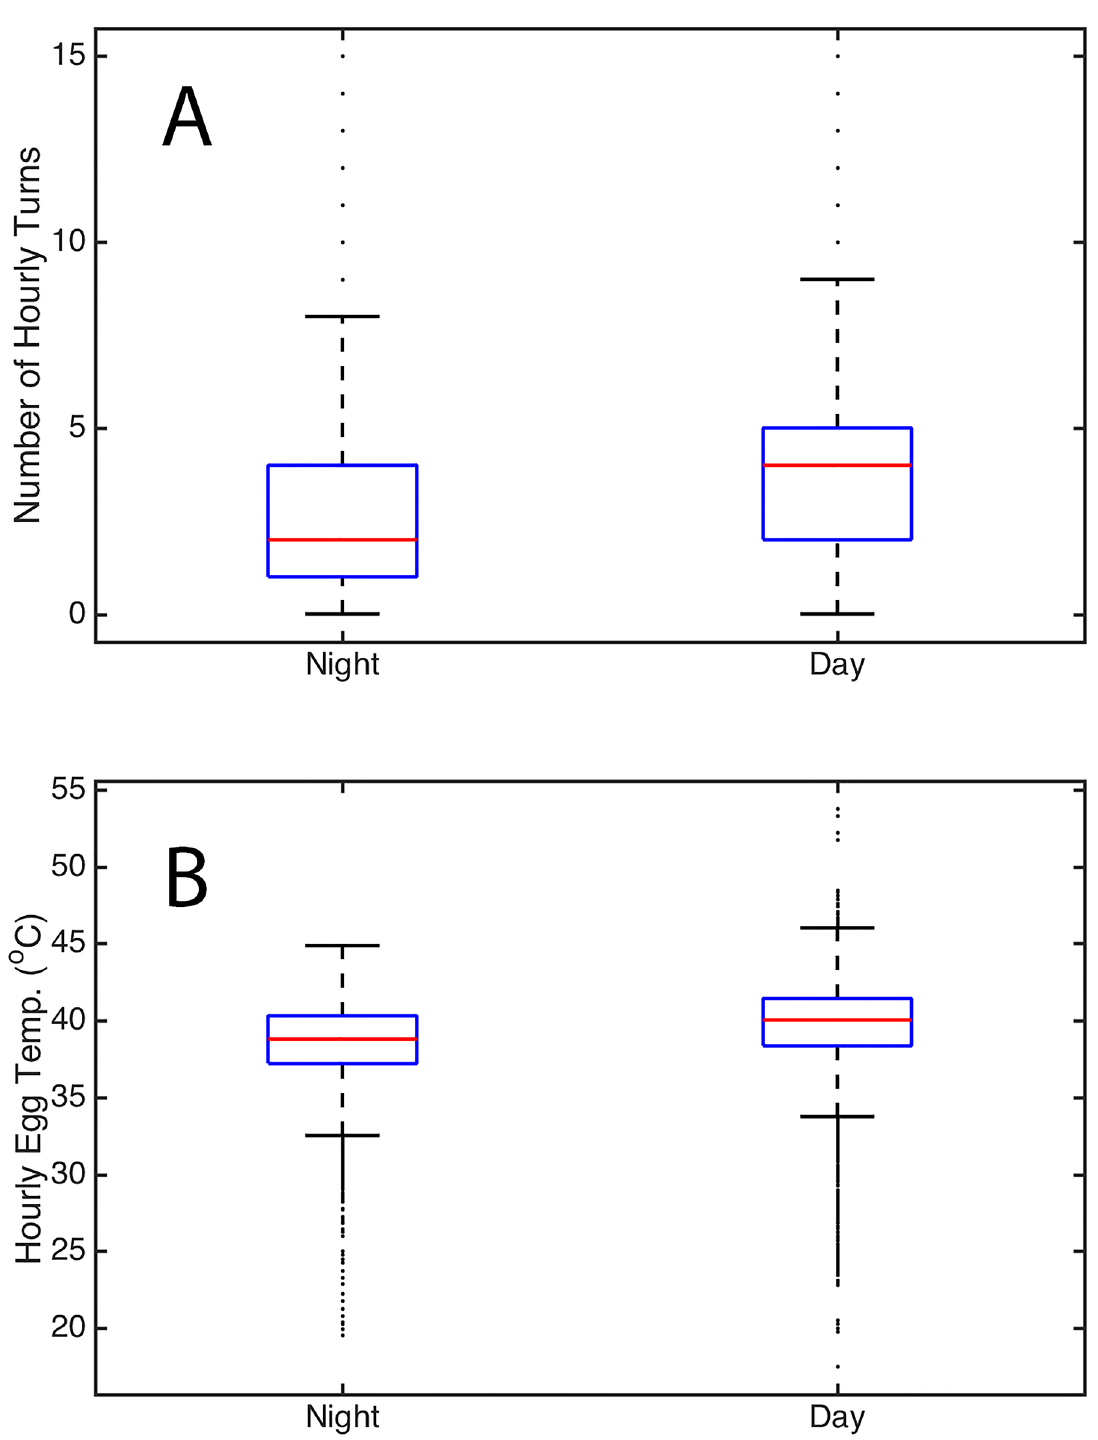
Fig 2. The hourly number of turns and egg temperature during the night and during the day in terns. (A) Hourly number of turns. (B) Egg temperature. The boxes denote the median, 25 & 75% quartiles, the range of data, and outliers.